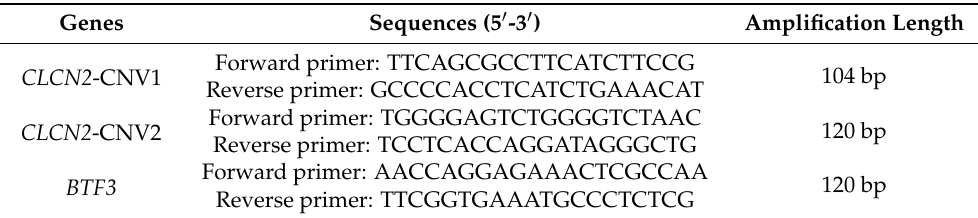
Figure 1. Information about the two CNV regions of CLCN2 gene in cattle breeds. Table 1. Primers designed for the genes used in this study.